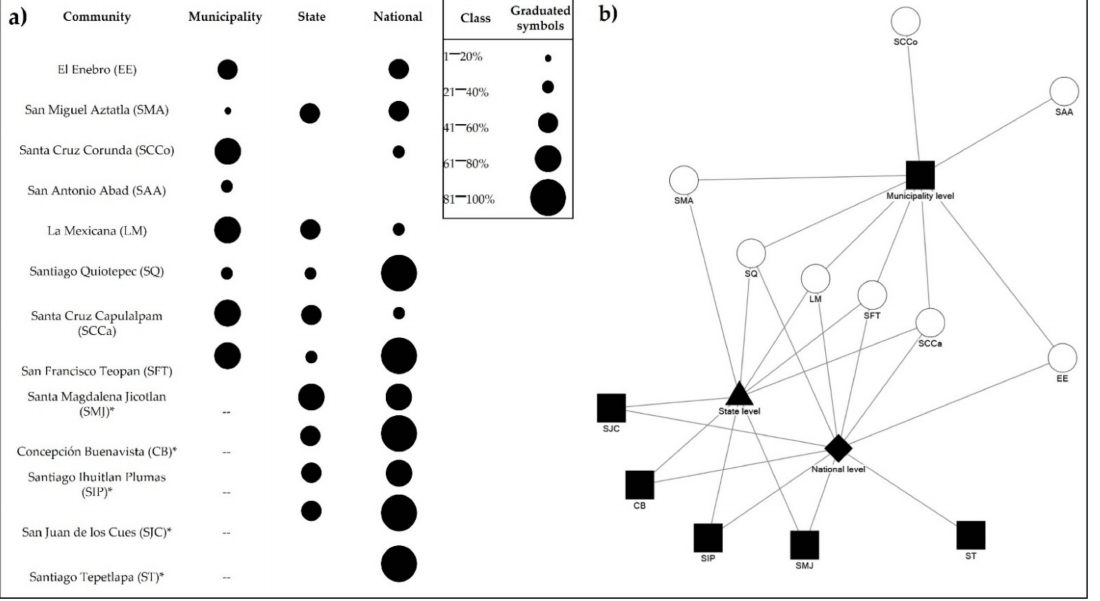
Figure 5. ( a ) Percentage of interviewees from each community who mentioned some interaction with the different stakeholders belonging to higher jurisdictional levels. Communities marked with an asterisk (*) are municipal seats that cannot be nested within themselves, so interactions at the municipal level were not considered. ( b ) Interaction scheme of the 13 communities studied with other actors at higher jurisdictional levels: municipal (square), state (triangle), and national (diamond). The communities where a municipal agent or a water committee administers the water supply system for domestic use are shown in a circle and the municipalities in squares. Abbreviation definitions can be found in ( a